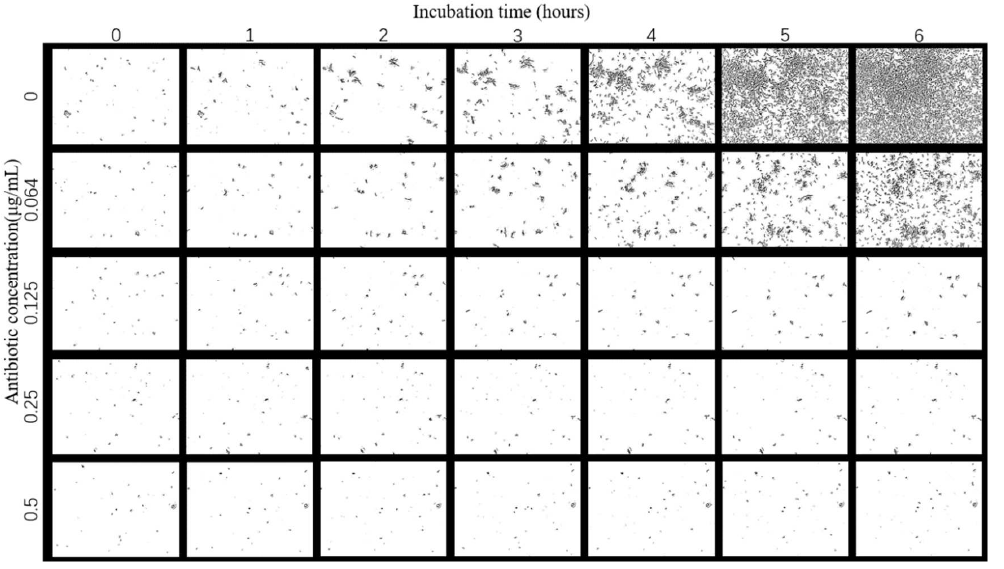
Figure 5. Segmentation